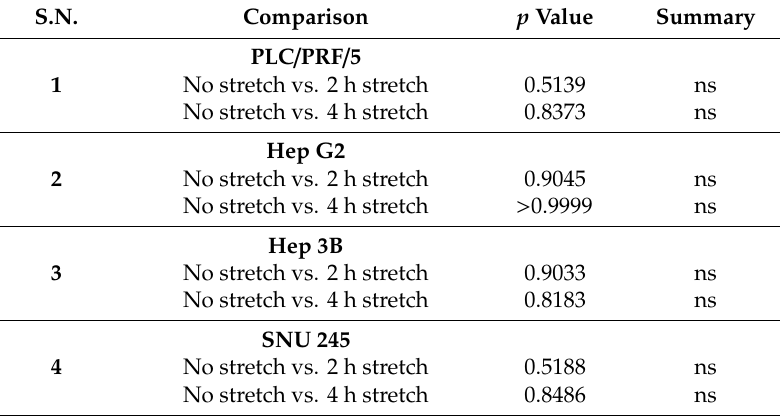
Figure A2. Time course of activation of AFP before and after stretching in four different types of liver cancer cells. We measured the released protein level at different durations of mechanical stretching, i.e., 0 hr (control), 2 hr and 4 hr. To quantify the level of the activity of AFP in response to stretching, ELISA detection method was used. ( A ) The quantitation of AFP activity in different cell lines before and after stretching for 2 hr and 4 hr; ( B ) ELISA detection of protein markers before and after stretching for 2 hr and 4 hr of PLC/PRF/5, Hep G2, Hep 3B and SNU 245 liver cancer samples. Table A1. p values obtained using Student’s t-test comparing the control and different durations of mechanical stretching of four different types of liver cancer cells.